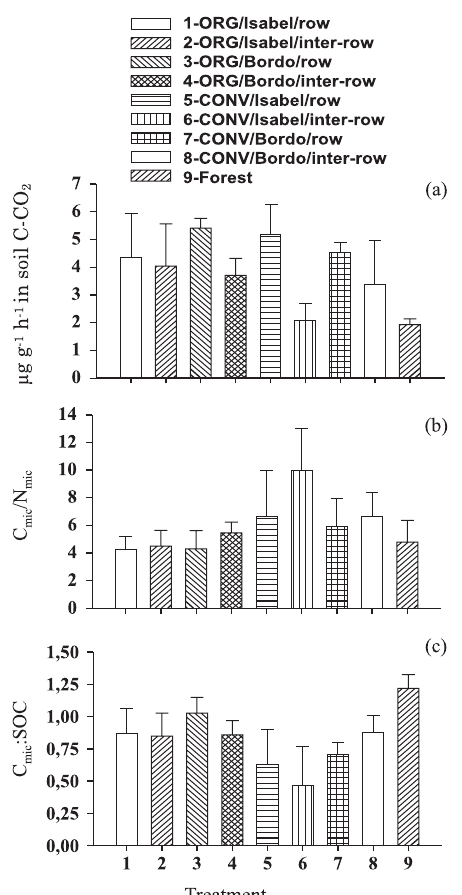
Figure 2. Microbial indices: (a) metabolic quotient ); (b) microbial carbon/nitrogen ratio and (qCO 2 (c) percentage of C in relation to SOC in soils mic after six years under organic (ORG) and conventional (CONV) vineyards and from an adjacent forest fragment. Vertical bars indicate standard deviation